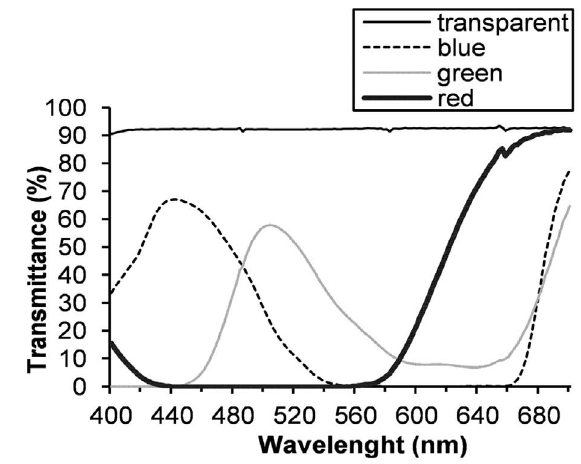
Fig. 1. – Spectral transmittance (%) of broadband spectra of differ- ent light qualities obtained from a combination of lamps and acrylic filters: transparent (equivalent to white light), green, red, and